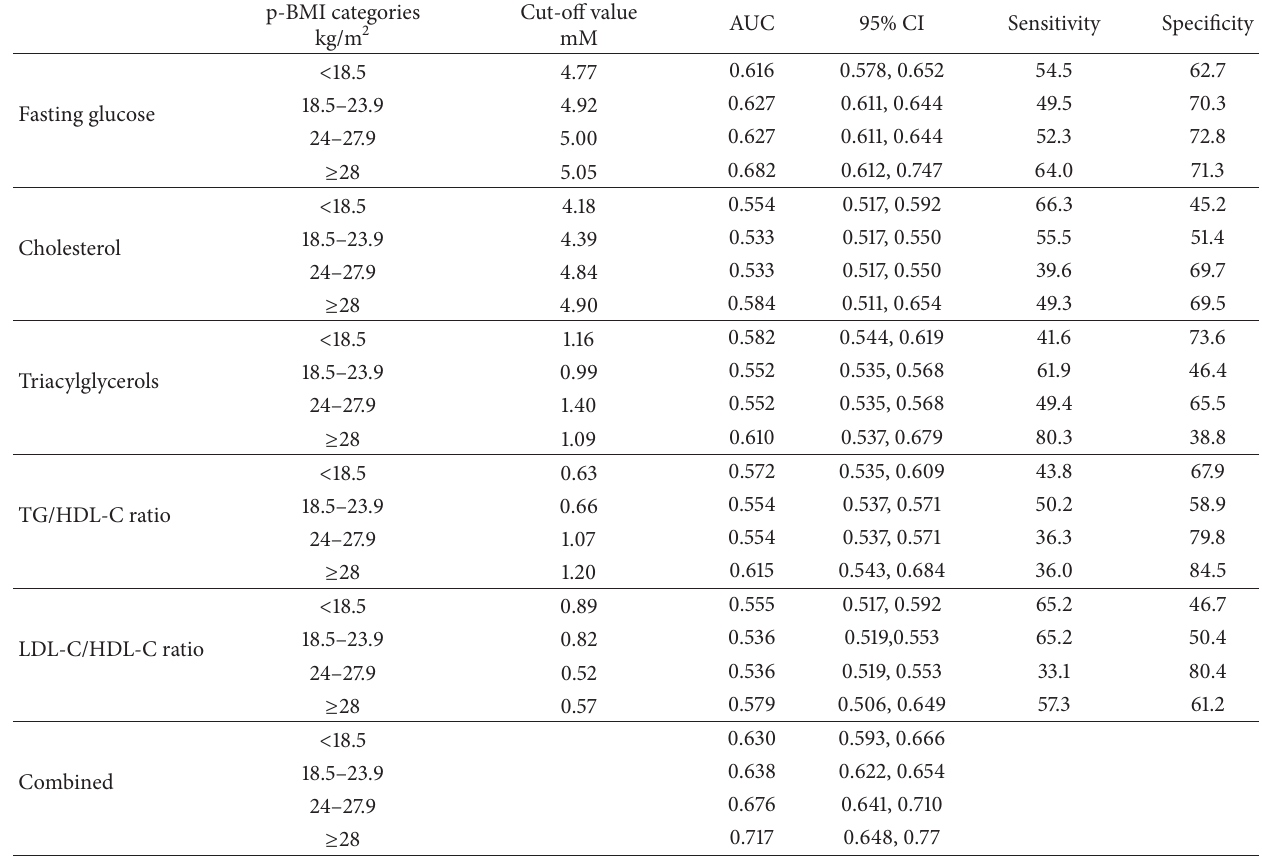
Table 4: The optimal cut-off value for each factor and their combined value for the detection of GDM stratified by